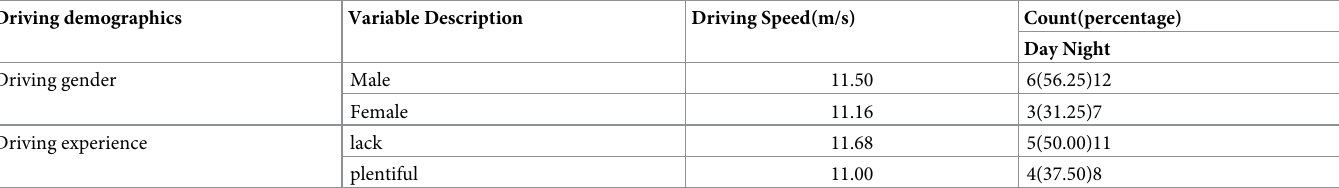
Table 3. Driving style score according to gender.